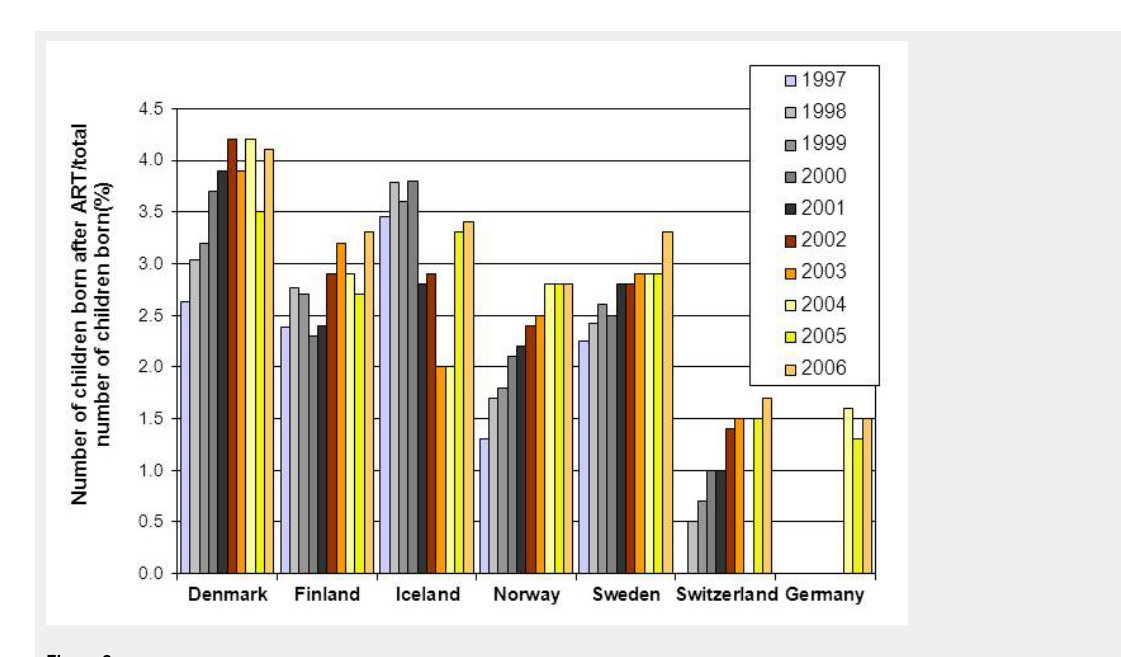
Figure 2 In those countries with a complete coverage of all deliveries after ART, its impact on the total number of neonates can be assessed. In most countries, the impact of ART as given by the number of neonates born after assisted reproduction is on the rise (Source: European IVF- monitoring Group (EIM) of ESHRE, ■■■). The relative number of neonates after ART (in %) is the highest in Scandinavian countries, where the treatment costs are covered by the health insurance. In Switzerland the 2004 data were not mentioned by EIM in their annual report, as were the data before 2004 in Germany due to incomplete coverage of deliveries after